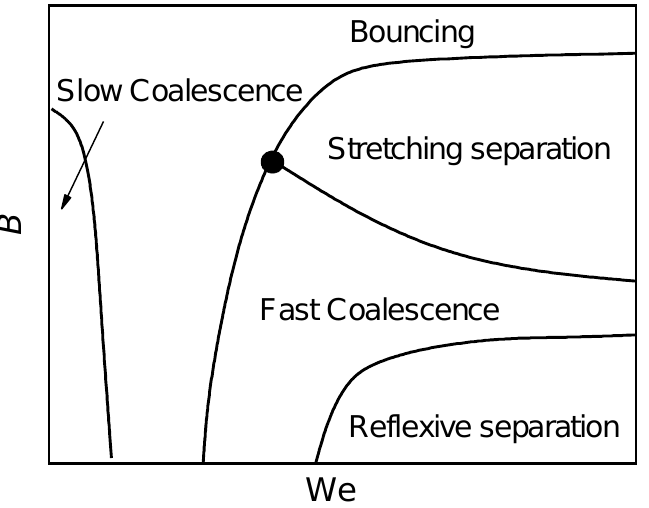
Figure 1. Droplet interaction regime map in the B (We) coordinates, using the data from [18,19]. Two approaches are widely used in outlining the collision regimes when plotting an interaction regime map. The first approach distinguishes [2,5,7] four droplet collision regimes (Figure 2): bounce, coalescence, separation, and disruption. Bounce is notable for the elastic collision of droplets followed by their moving away from each other. The droplet surface remains intact and new droplets are not formed. During coalescence, the droplet surface disrupts at the point of contact, and two droplets merge into one large drop. In the separation regime, droplets merge and then separate without forming any new droplets. The disruption regime occurs when several secondary fragments are formed after parent droplets collide. In line with the second approach [2,6,7,16,18,19], five collision regimes are distinguished: fast coalescence, slow coalescence, bounce, stretching separation, and reflexive separation. The main difference between fast and slow coalescence is the duration of coalescence of parent droplets. Slow coalescence occurs when the Weber number is under 10. As part of reflexive separation, droplets coalesce and then break up into two to three child (satellite) droplets [16]. Stretching separation, also known as shift of layers, is notable for the formation of a liquid bridge between the colliding droplets, which then breaks up into a group of small fragments. Figure 2 also reports the location of the triple point, in which several interaction regimes can occur and which is often marked on regime maps [20,21].